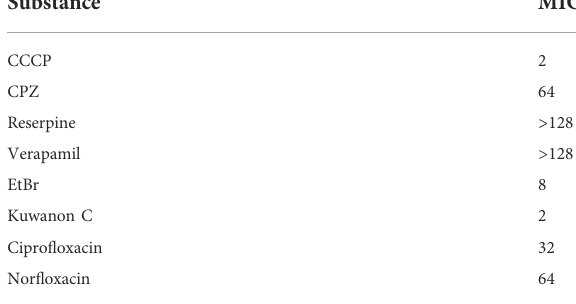
TABLE 5 MIC (µg/ml) of EtBr, standard EPIs, antibiotics, and kuwanon C against MRSA 7109.